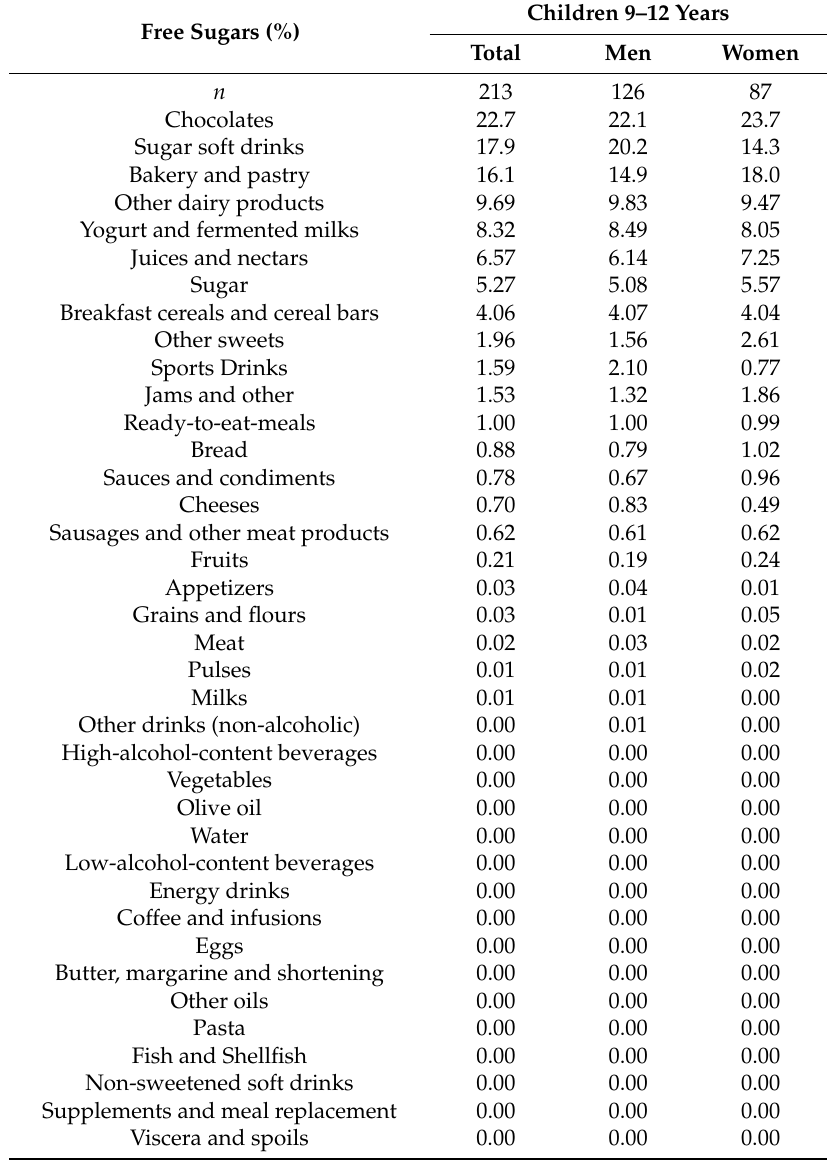
Table 11. Dietary sources of free sugars (%) from food and beverage subgroups in the ANIBES Study Spanish population aged 9 to 12 years: